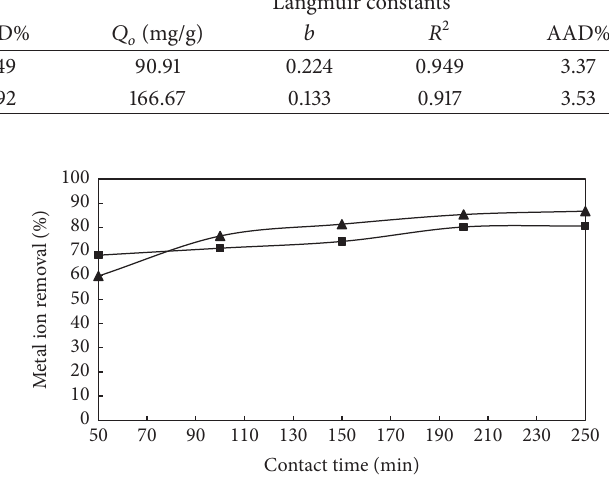
Figure 4: Percentage of Ni 2+ ( ◼ ) and Zn 2+ ( 󳵳 ) ions removal with varying pH.